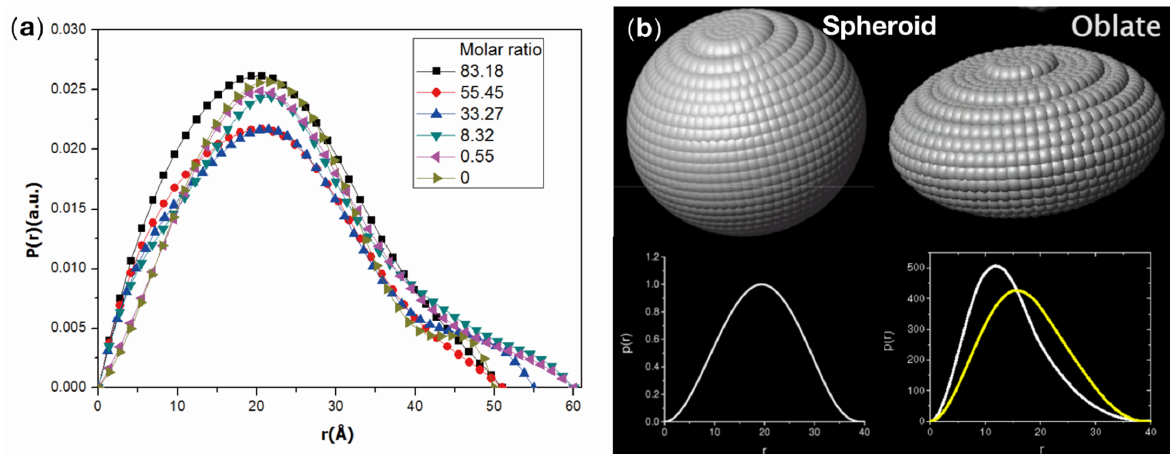
Figure 3. ( a ) Distance distribution functions from the complexes. ( b ) The molecular shape of trypsin at low (right) versus high (left) concentrations of EGCG.